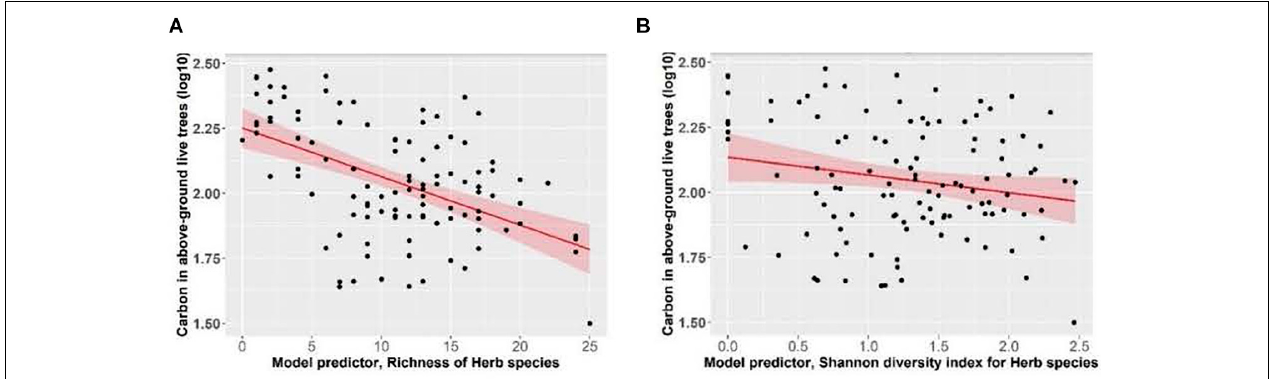
FIGURE 8 | Effect of panels (A) herb species richness and (B) herb species Shannon diversity index, on carbon stored in above-ground live trees (live trees that have a DBH > 1.3 cm; data includes stems, foliage, branches and bark) of Douglas-fir dominated forests. Linear mixed-effects models were used to estimate the Marginal R 2 = 0.17 (A) and R 2 = 0.04 (B) . Each data point represents one measurement per plot (113 plots in total). Carbon in above-ground live trees (Mg ha − 1 ) was log 10 -transformed, and the figure presents log 10 -transformed